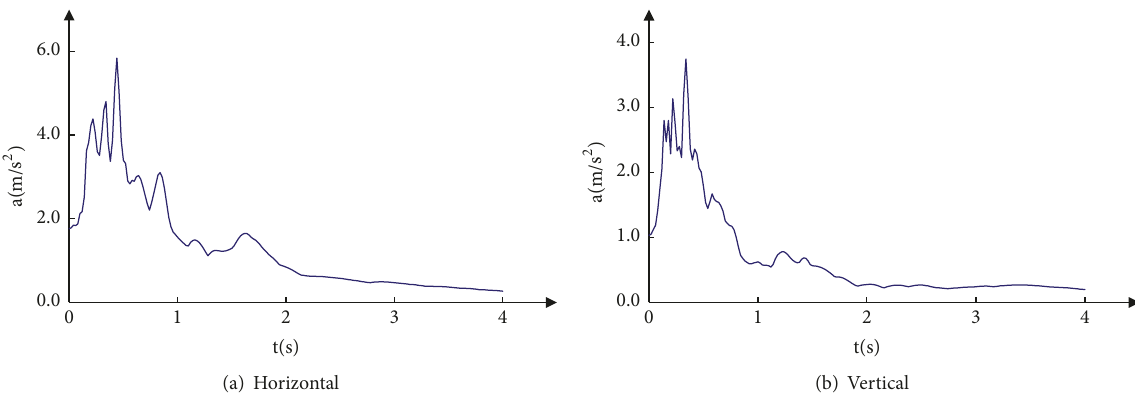
Figure 16: Acceleration spectrums of Taft earthquake: (a) horizontal and (b) vertical.